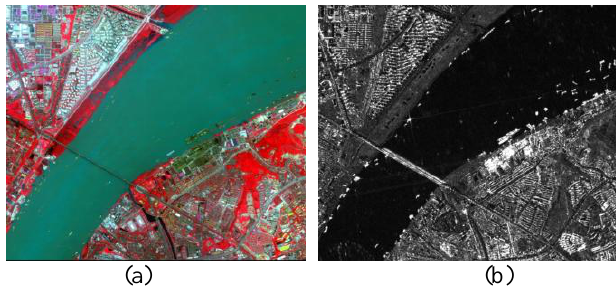
Figure 1. Images of study area, (a) is the Standard false-color composite image of QuickBird, and (b) is TerraSAR-X HH